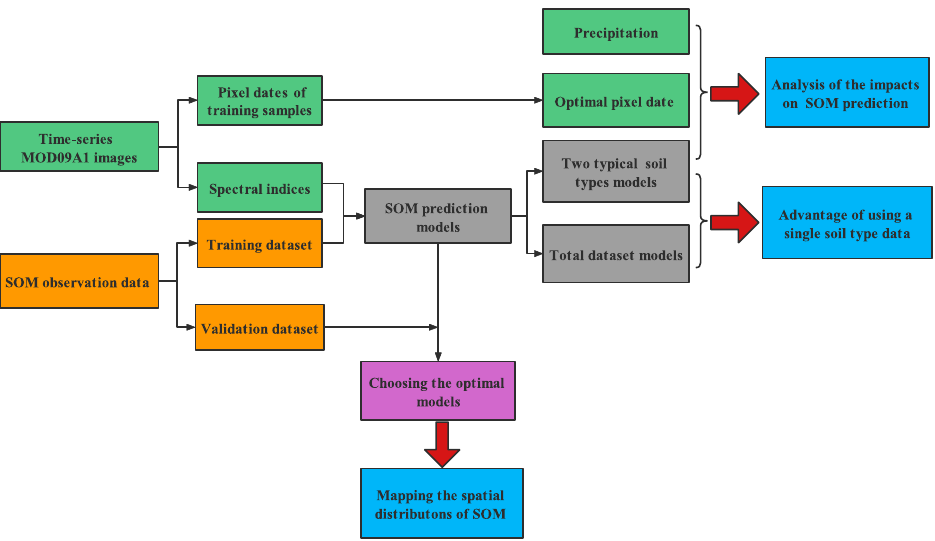
Figure 1. Workflow schematic for analyzing the prediction accuracy of regional soil organic matter (SOM) and mapping its spatial distribution. Notably, the models using two single soil types data (i.e., Arenosols and Phaeozems) are called the “two typical soil types models” and using the total dataset are called the “total dataset models”.